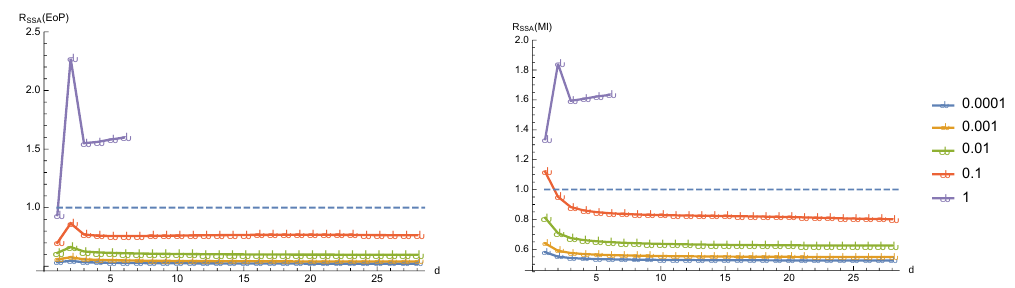
Figure 17 . The ratio R SSA of the strong superadditivity of EoP (left) or mutual information (right). R SSA < 1 means the violation of the strong superadditivity. For almost all massless